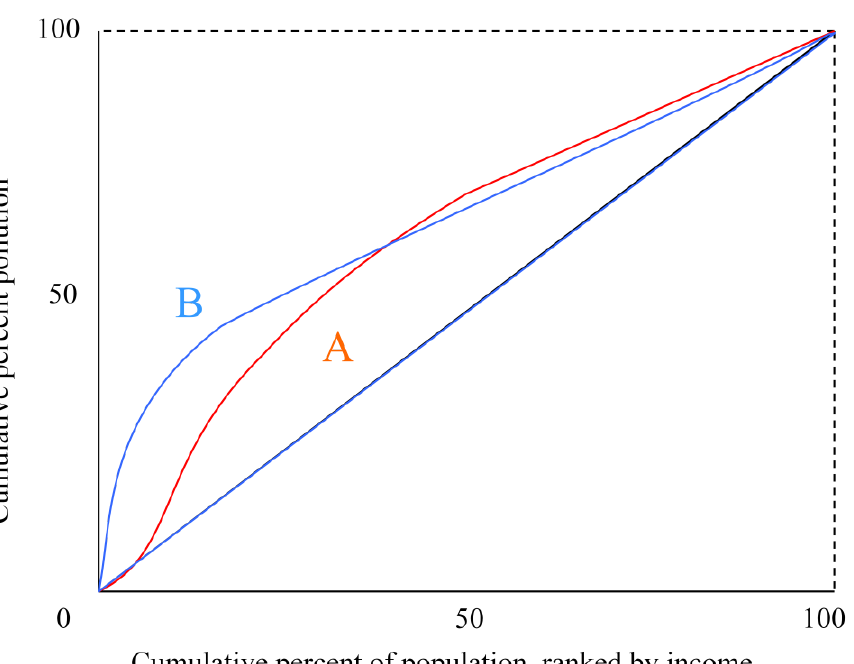
Figure 2. Concentration